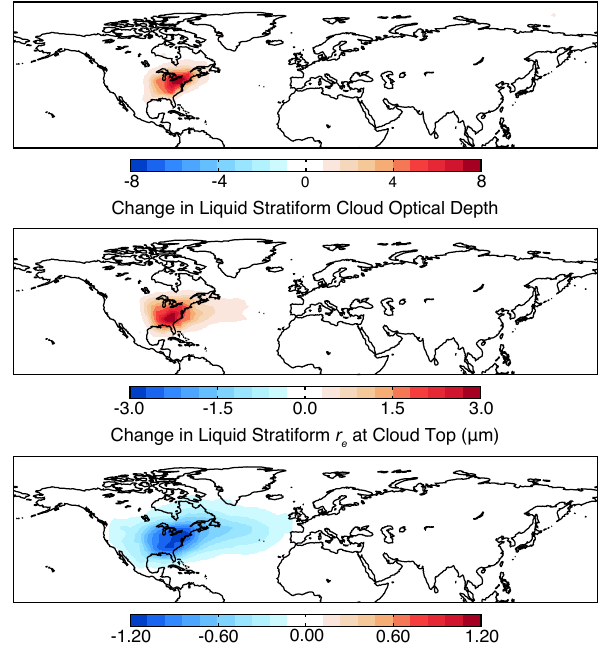
Fig. 9. Effect of US anthropogenic aerosols on column integrated cloud droplet number concentration, liquid stratiform cloud droplet effective radius at cloud top ( r e ) , and liquid stratiform cloud optical depth. Values are annual model means for